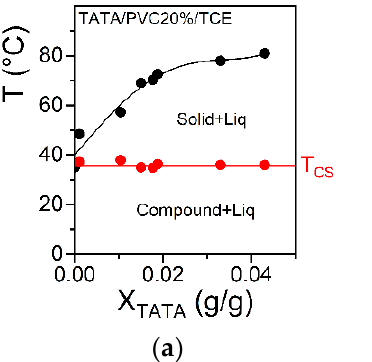
Figure 6. ( a ) Temperature–TATA concentration phase diagram in tetrabromoethane (TBE) as mapped out by DSC at 5 °C/min. A non-variant first-order transition can be seen at T = 40 °C corresponding to the de-solvation of compound C1 into another less solvated compound C2 or a solid phase S. The final melting of the gel was concentration-dependent. The red line is a guide for the eyes. ( b ) cryoSEM micrograph for PVC5%/TATA1.5% in bromobenzene. The TATA fibrils (long ribbons highlighted by arrows) can be clearly distinguished from the surrounding PVC network.